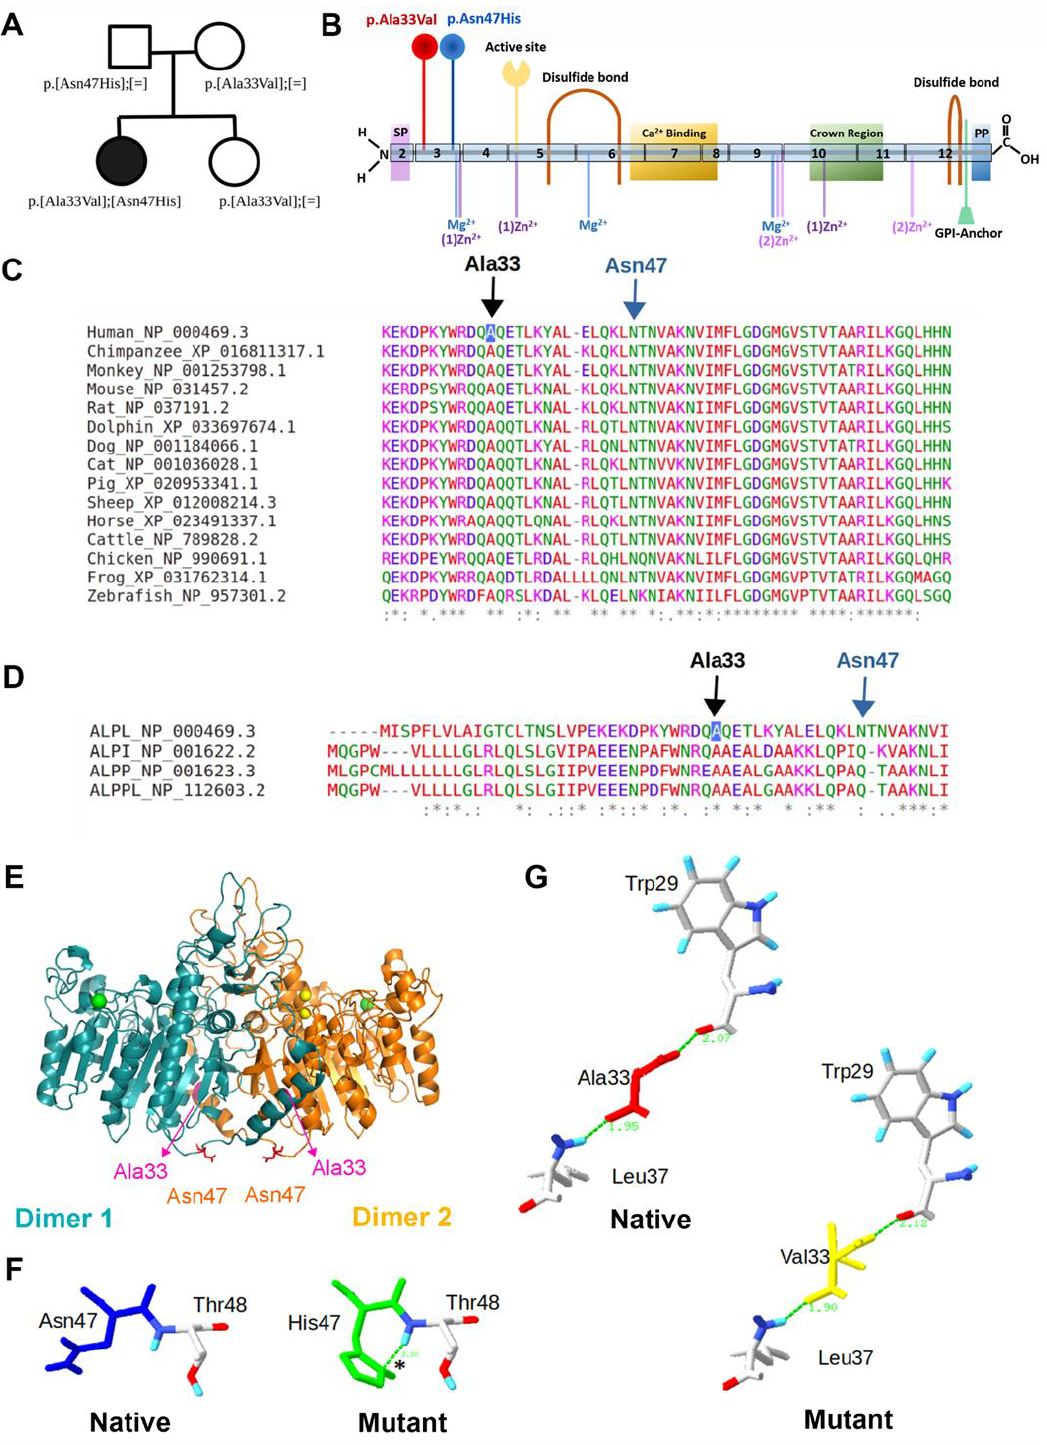
Figure 2. Genetic and pedigree analysis. ( A ) Pedigree chart representing two generations of the family analyzed in this study. Segregation patterns of genotypes (p.Ala33Val and/or p.Asn47His)